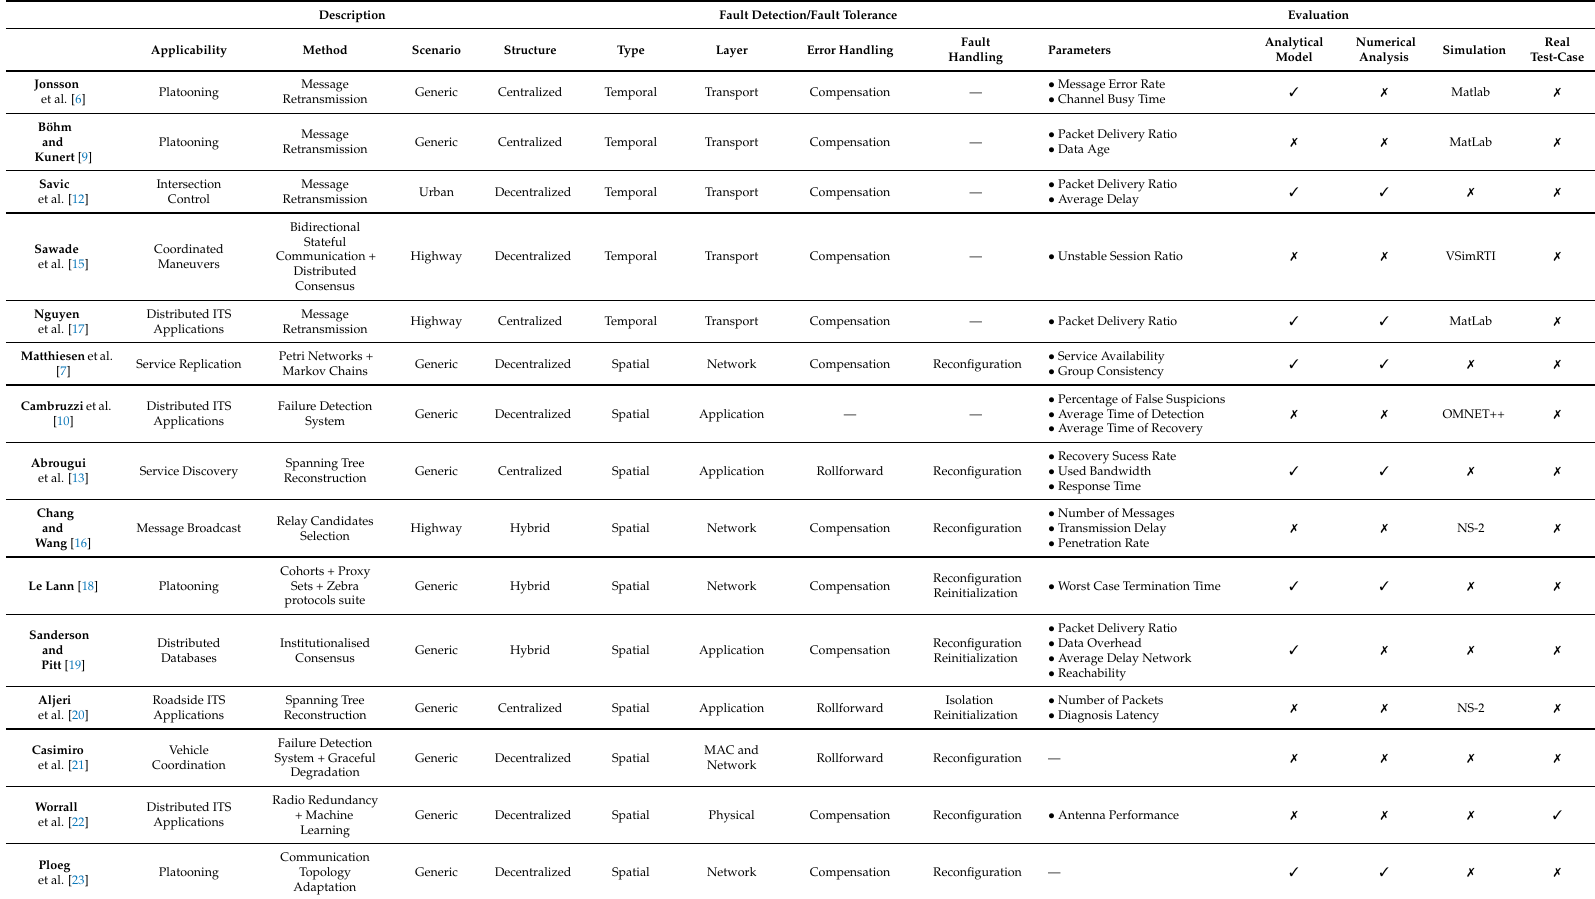
Table 2. Comparison of selected documents.